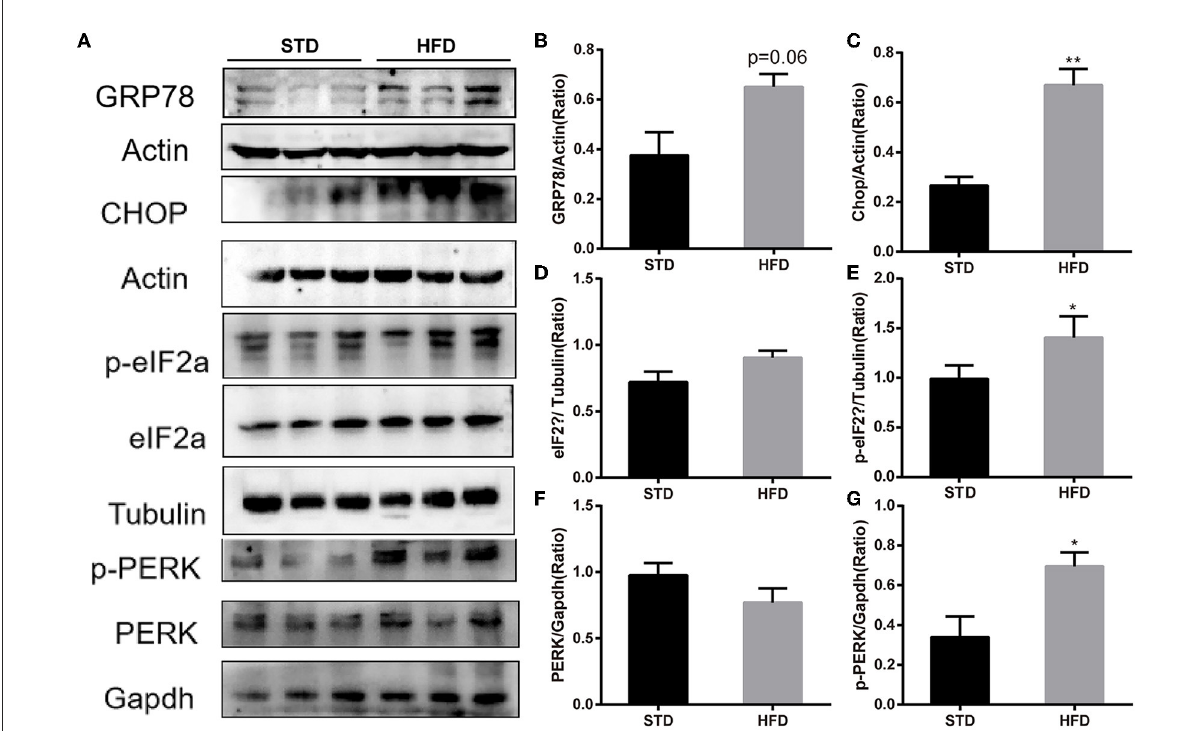
FIGURE9 Western blot analyses of GRP78, CHOP, PERK, p-PERK and eIF2 α , p-eIF2 α in hippocampal. (A) The band of western blot for GRP78, CHOP, PERK, p-PERK and eIF2 α , p-eIF2 α . (B–G) Densitometric data of GRP78, CHOP, PERK, p-PERK and eIF2 α , p-eIF2 α expression using ImageJ are presented as the means ± SEM of 3 independent experiments, n = 3,3. * P < 0.05; ** P <